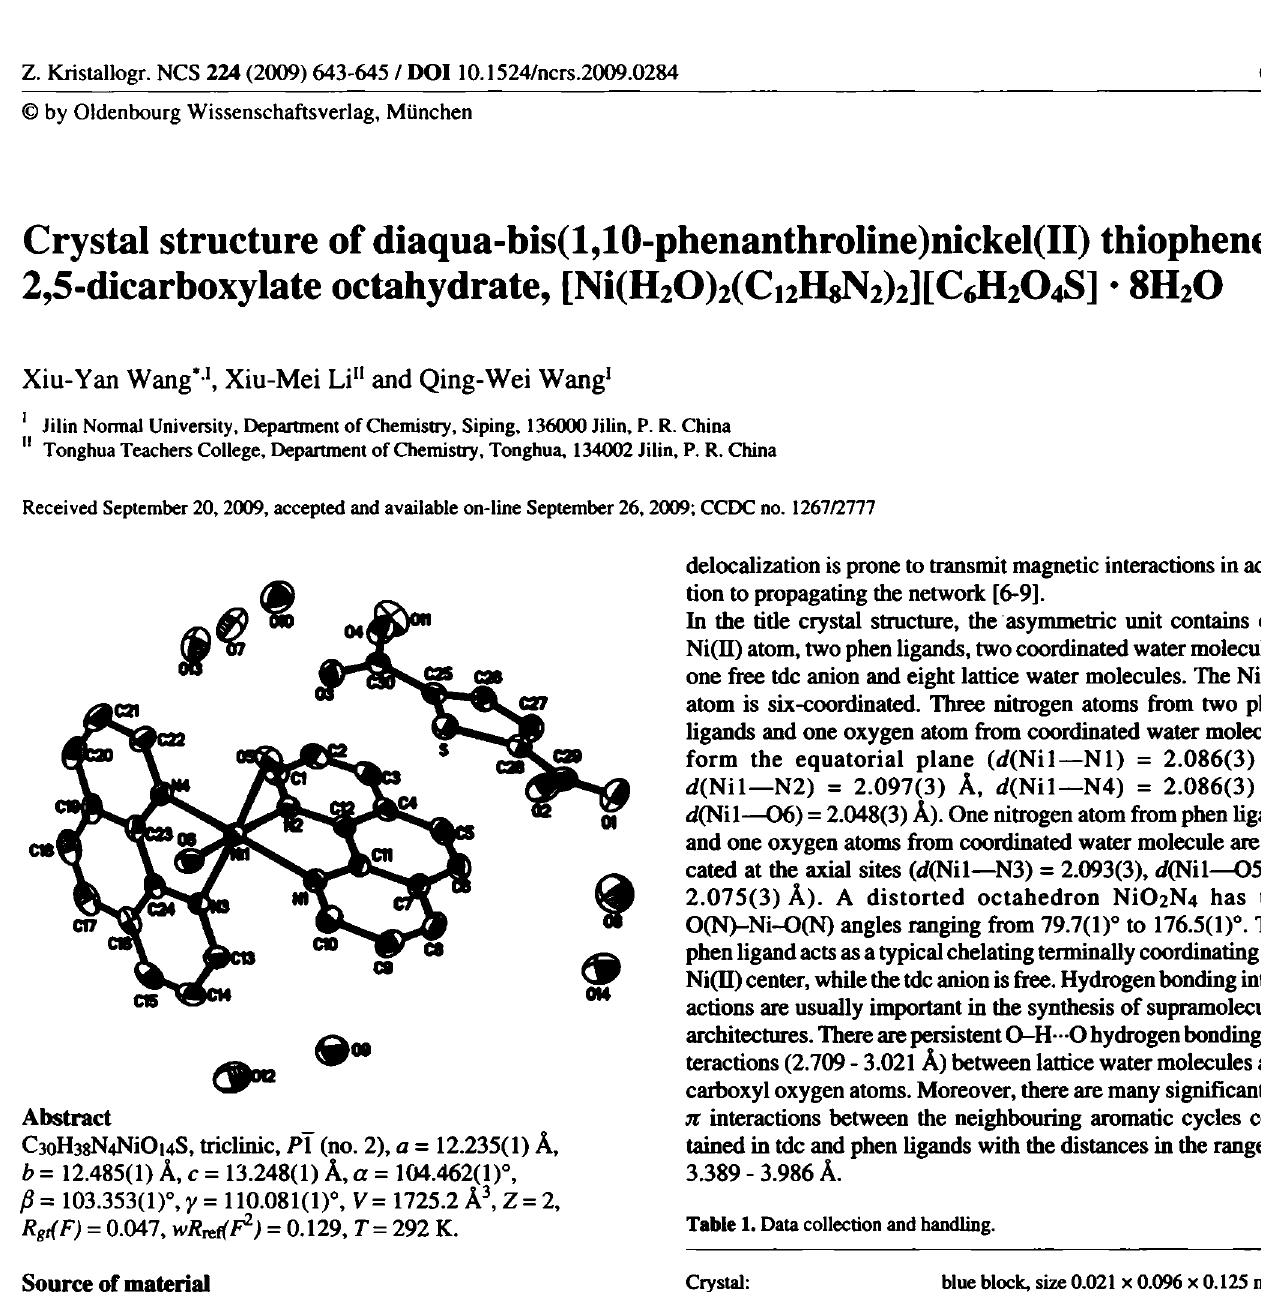
Table 2. Atomic coordinates and displacement parameters (in Â 2